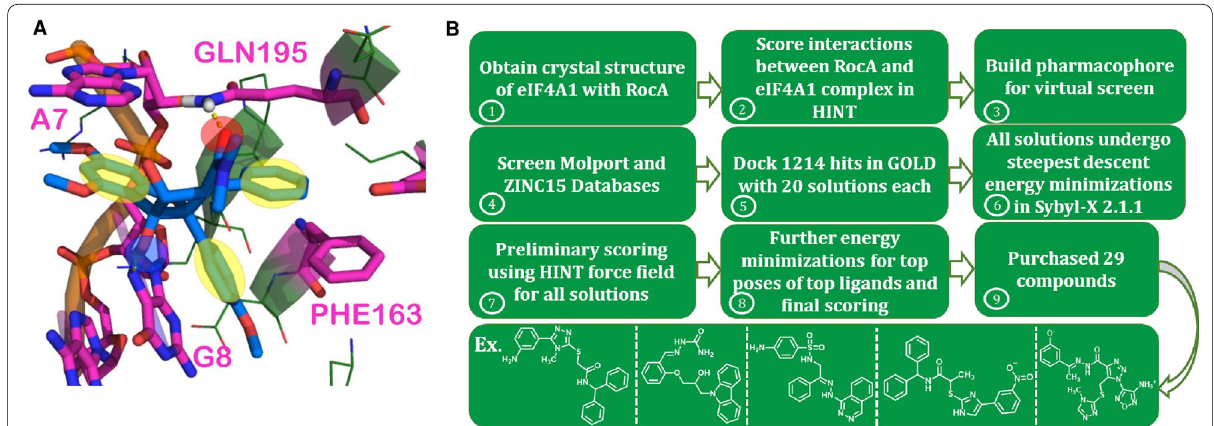
Fig. 2 Flow chart representing the process taken to identify new small molecule inhibitors for eIF4A. A Model of RocA used to define important pharmacophore features used in pharmacophore-based virtual screening experiment. In yellow circles are shown regions defining positioning of aromatic rings. The red circle indicates a hydrogen bond acceptor feature, while the blue circle indicates a hydrogen bond donor feature B Workflow for virtual screening strategy that identified RBF98 as the top hit. Stages for this workflow included obtaining the crystal structure of eIF4A1 complexed with RocA, scoring interactions between these two species, constructing and implementing the virtual screening pharmacophore, high-throughput molecular docking, energy minimizations of solutions, preliminary scoring of solutions in HINT, and final energy minimizations and scoring, followed by the purchase of the 29 top-scoring